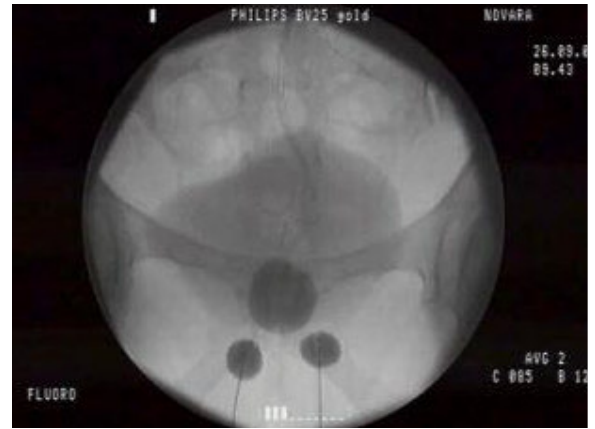
FIGURE 4. Cystogram showing a correct location of the